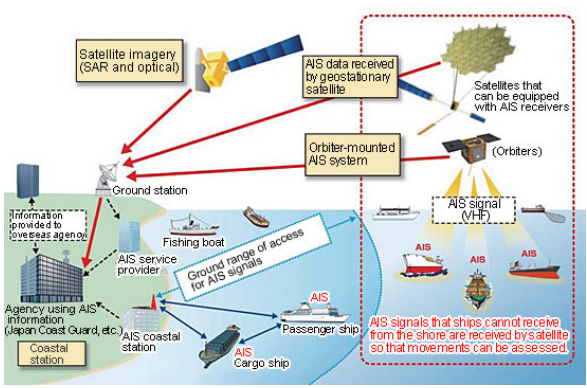
Figure 1. Using AIS equipment vessels automatically broadcast ship specific information, such as their name and type, as well as their position to nearby vessels or coastal stations. On oceans Satellite-based AIS (S-AIS) can be